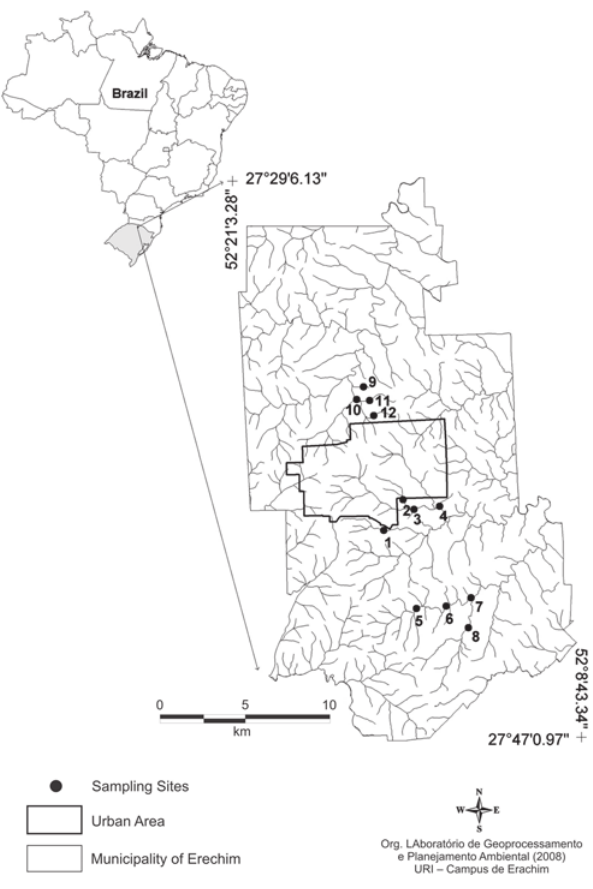
Figure 1. Dsitribution of the sampling sites in the municipality of